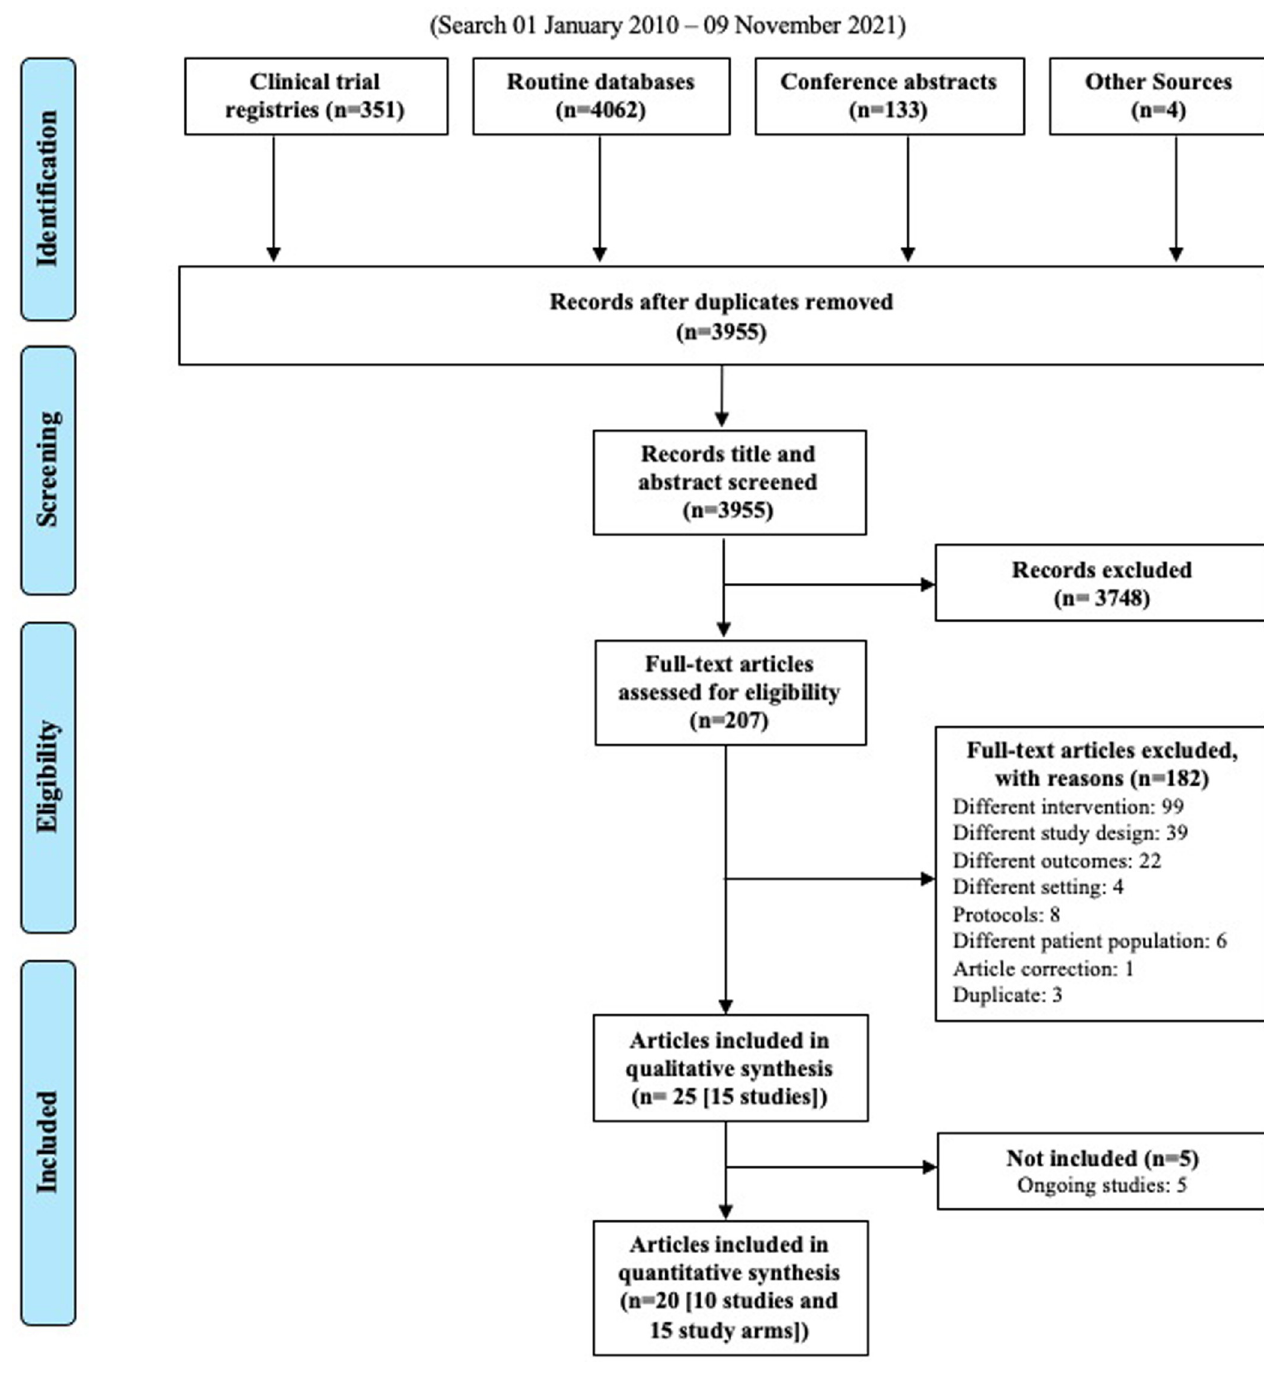
Fig 1. PRISMA search